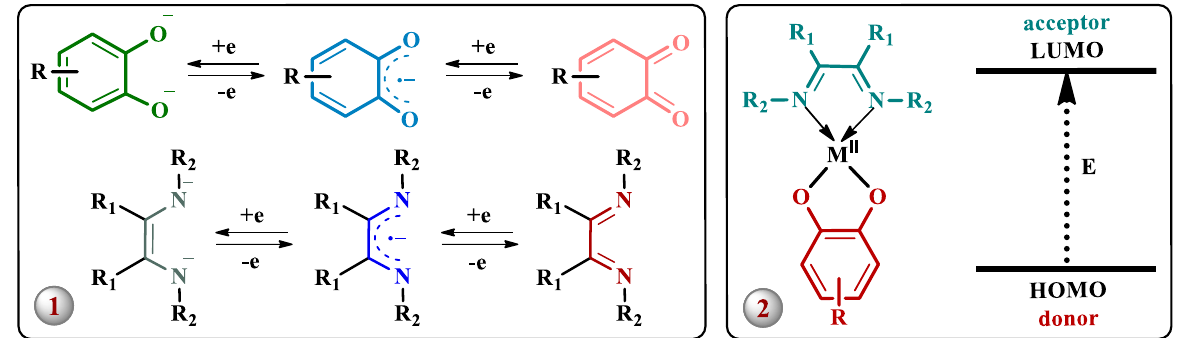
Scheme 1. Redox states of o -benzoquinone and α -diimine type ligands ( 1 ); ligand-to-ligand charge transfer HOMO catecholate → LUMO α -diimine ( 2 ).